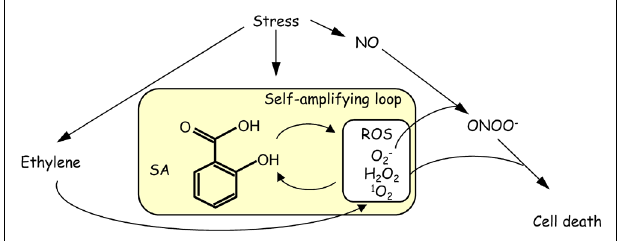
FIGURE 2 | Schematic model of a self-amplifying feedback loop between SA and ROS in response to